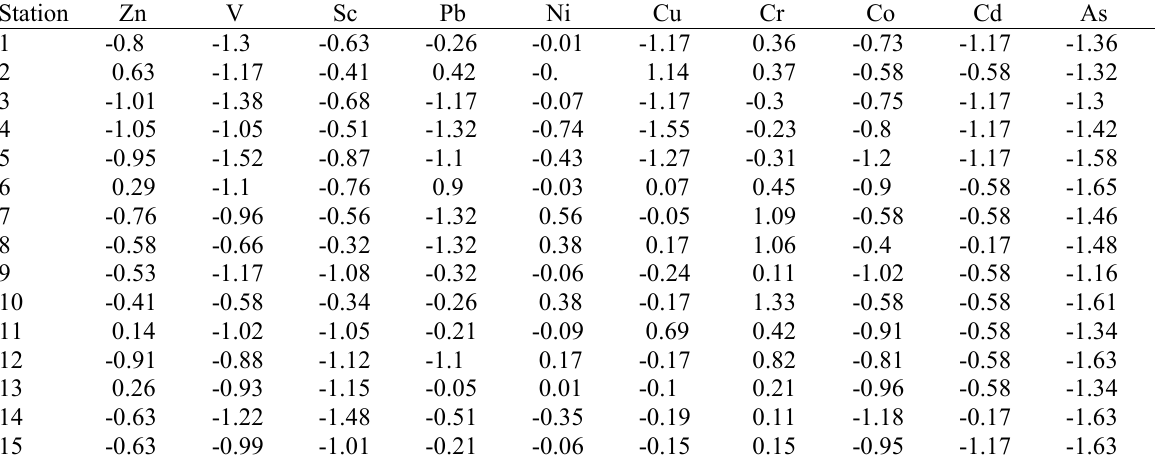
Table 3. Findings based on geoaccumulation index in soil of Kermanshah Refinery, Iran